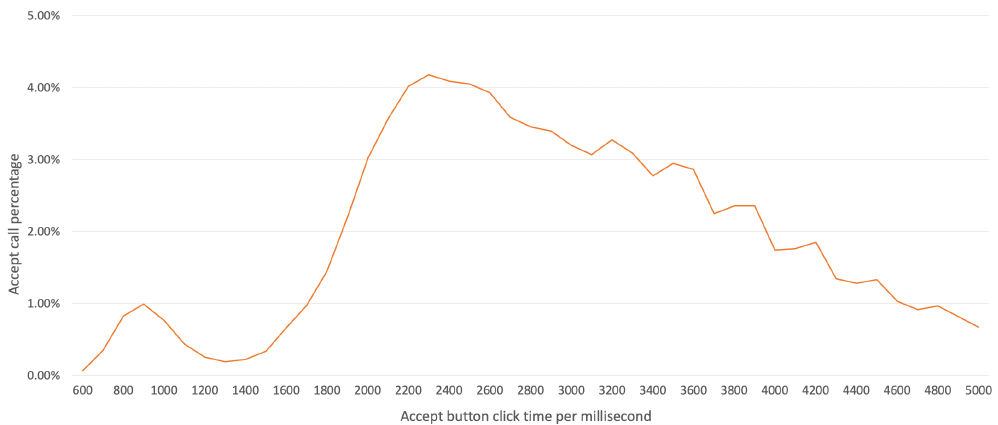
Figure 7. Acceptance button click rates per 100